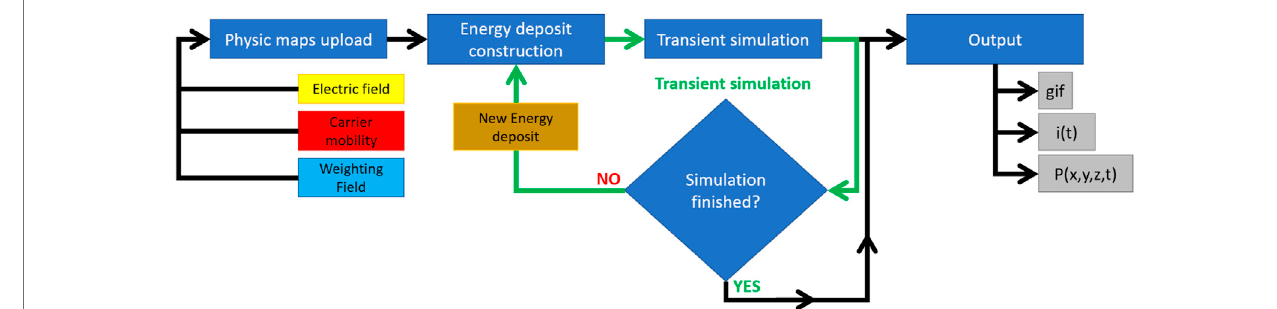
FIGURE 1 | The TCoDe simulation fl ow.